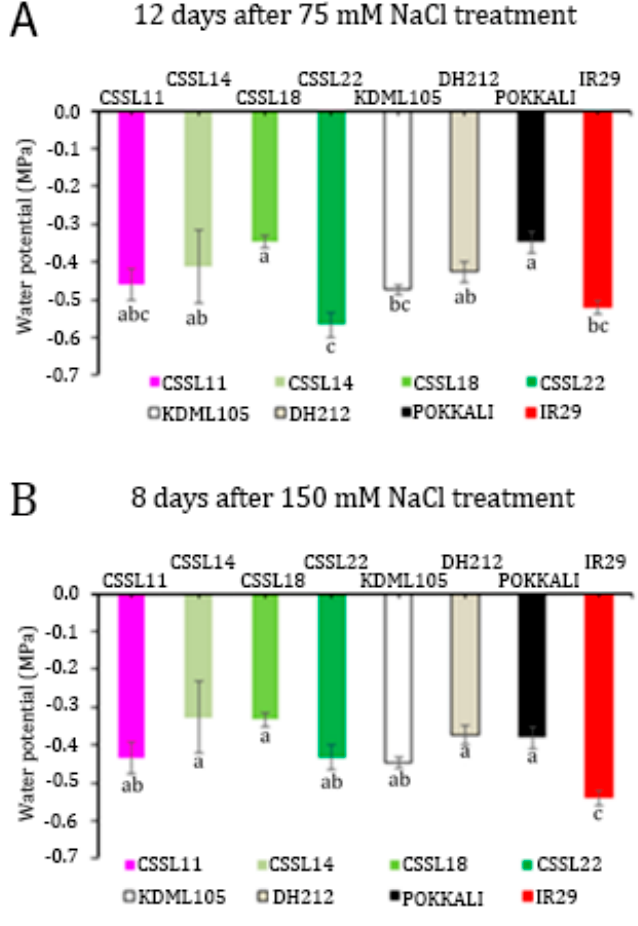
Figure 2. Leaf water potential of four CSSLs, parental lines (‘KDML105’ and DH212), and salt-tolerant (‘Pokkali’) and salt-susceptible (IR29) lines treated with 75 mM NaCl for 12 days ( A ) and 150 mM NaCl for 8 days ( B ). The di ff erent lower case letters show the significant di ff erence of means, p < 0.05. ‘Pokkali’ had the highest shoot and root fresh weights when the seedlings were treated with 150 mM NaCl for 14 days. CSSL18 and ‘KDML105’ had similar shoot fresh weights, which were significantly lower than the shoot fresh weight of DH212. The other CSSLs and IR29 had shoot fresh weights that were lower than those of both parents (Figure 3A). However, CSSL14 and CSSL18 had higher root fresh weights than both parents (Figure